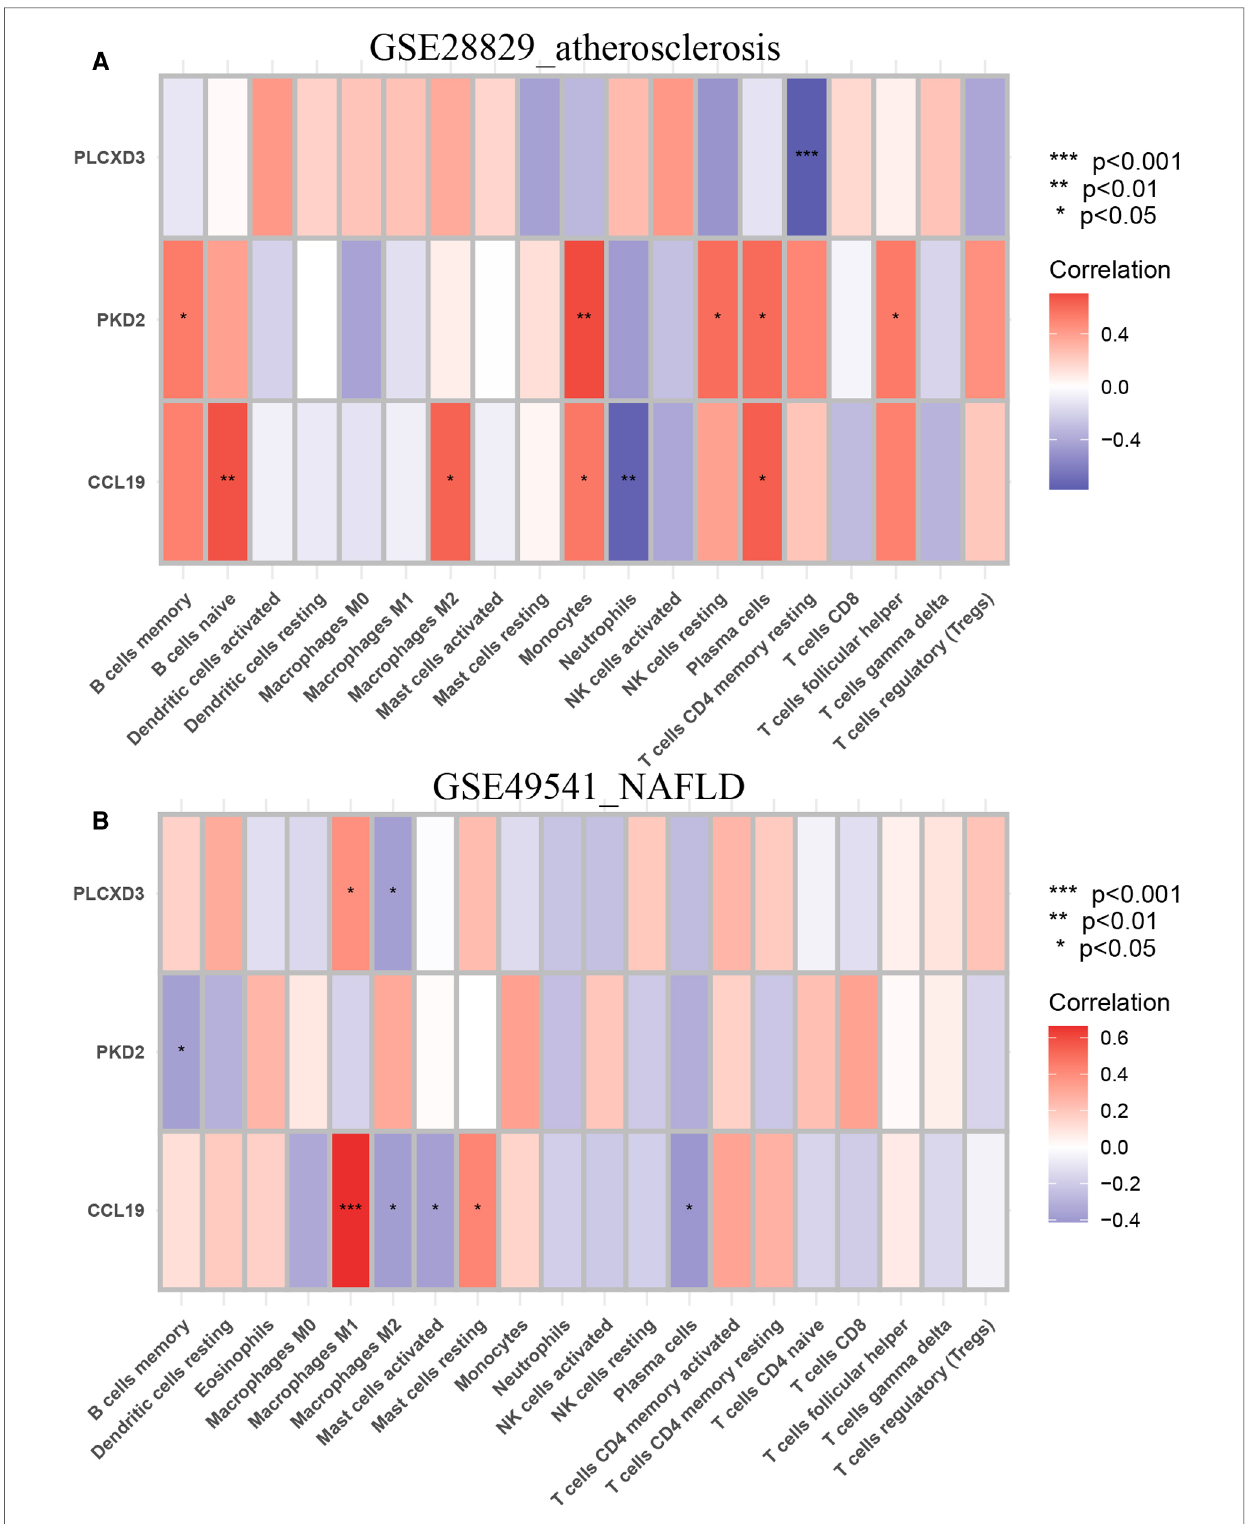
FIGURE 13 Immune in fi ltration analysis of the CIBERSORT algorithm. ( A ) The heatmap of the correlation coef fi cient between each common signature gene and each immunocyte subtype in GSE28829; ( B ) the heatmap of the correlation coef fi cient between each common signature gene and each immunocyte subtype in